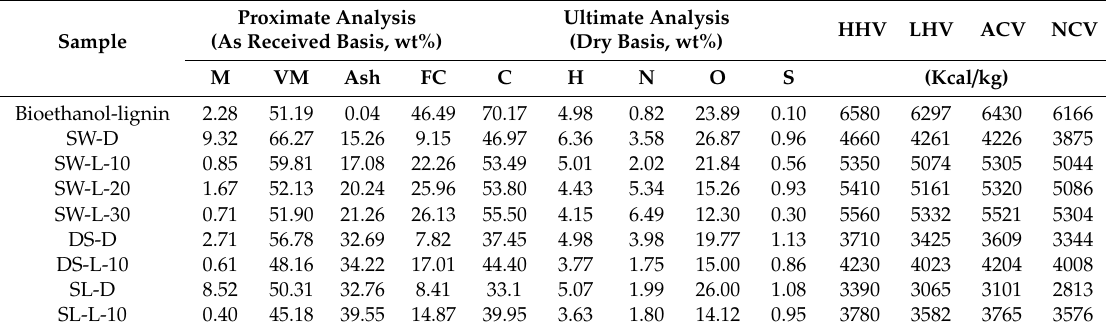
Table 1. Proximate analysis and ultimate analysis results, and calorific value of dried sewage sludge, bioethanol-lignin, and hybrid sewage sludge fuel (HSF) samples.